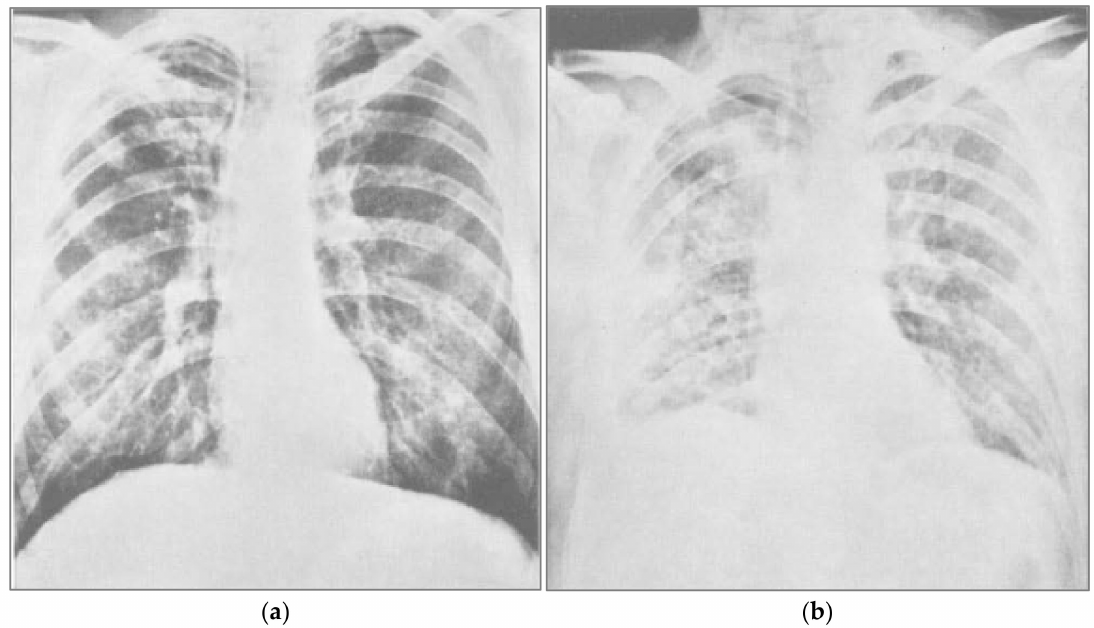
Figure 1. Pulmonary congestion following sodium chloride infusion. ( a ) Patient before a large infusion of sodium chloride and water in a 1969 controlled clinical trial. ( b ) Same patient two days after infusion, showing severe congestion from pulmonary edema due to fluid retention. Reprinted from Hutchin et al., 1969 (132). Pulmonary congestion following infusion of large fluid loads in thoracic surgery patients, The Annals of Thoracic Surgery, 8(4), 339–347, with permission from